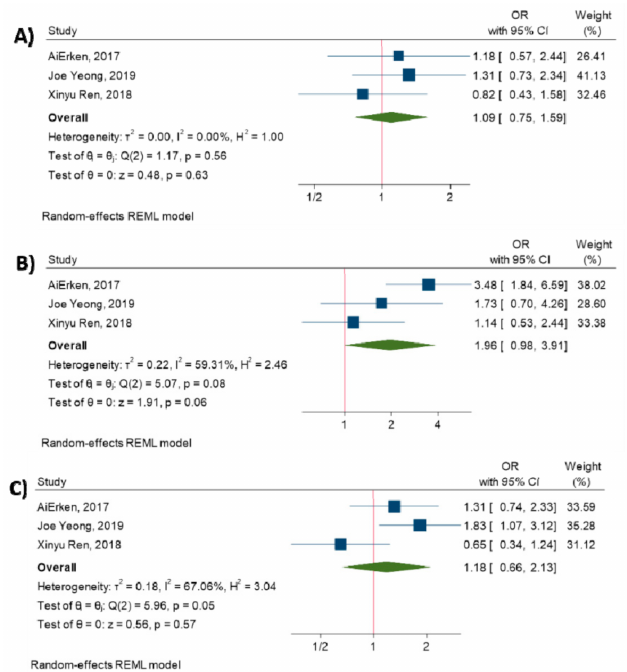
Figure 3. Forest plot of the individual odds ratio for the relation between TILs and clinicopathological characteristics. ( A ) tumor size, ( B ) tumor stage, ( C ) lymph node metastasis.